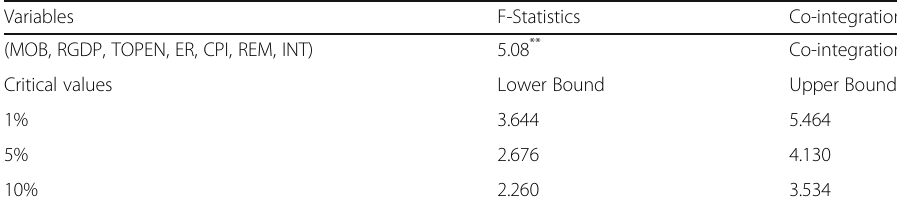
Table 4 Value of mobile transactions is the dependent Variable